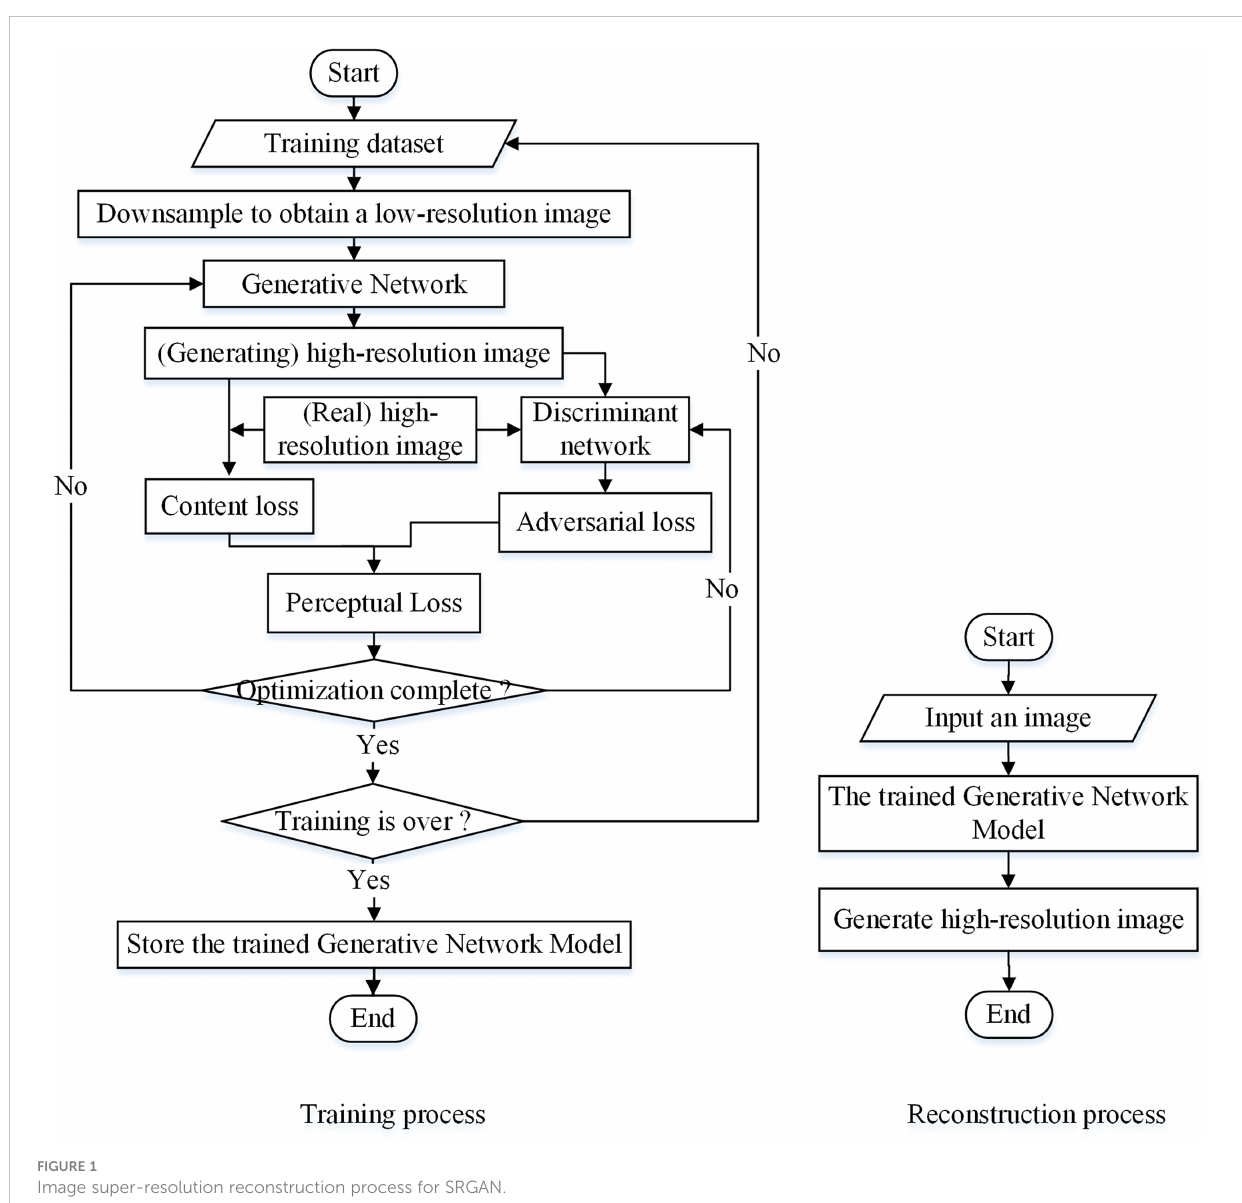
FIGURE 1 Image super-resolution reconstruction process for